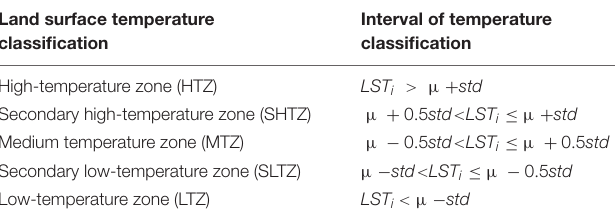
TABLE 1 | Urban heat island temperature classification using mean-standard deviation